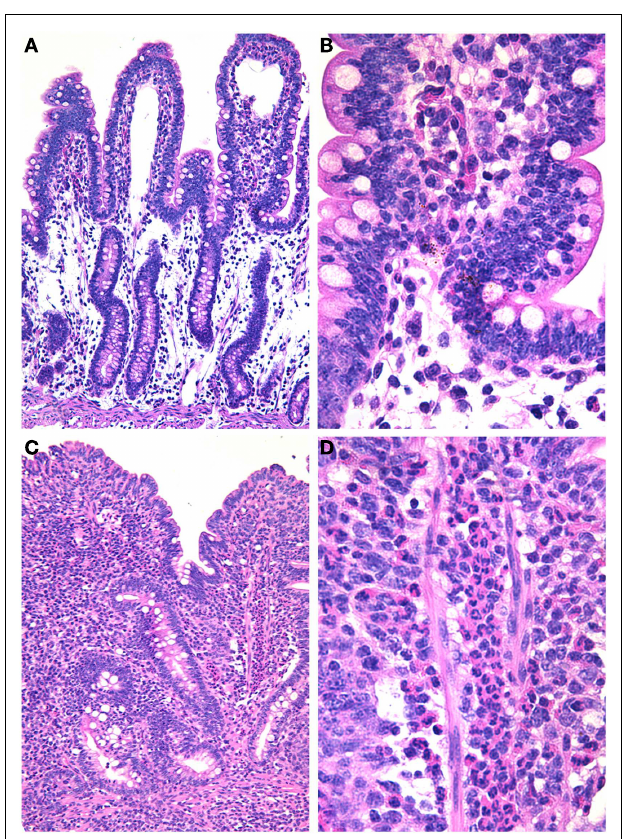
FIGURE 1 | Salmonella -induced enteritis in experimentally infected ligated ileal loops in calves . (A) Uninfected loop with no inflammatory reaction; 10 × objective. (B) Higher magnification of uninfected loop; 40 × objective. (C) Salmonella -infected loop with a severe and diffuse inflammatory infiltrate and blunting of the villi; 10 × objective. (D) Higher magnification showing a diffuse and severe infiltration of neutrophils; 40 × objective. Hematoxylin and